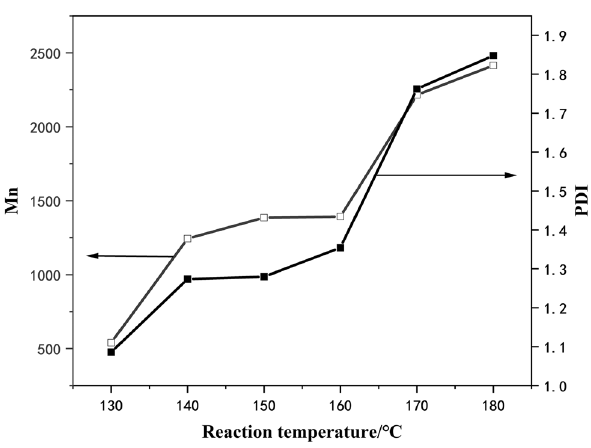
Figure 3: The e ff ect of reaction temperature on the M n and PDI of PCL diol ( the reaction temperature was 150°C )